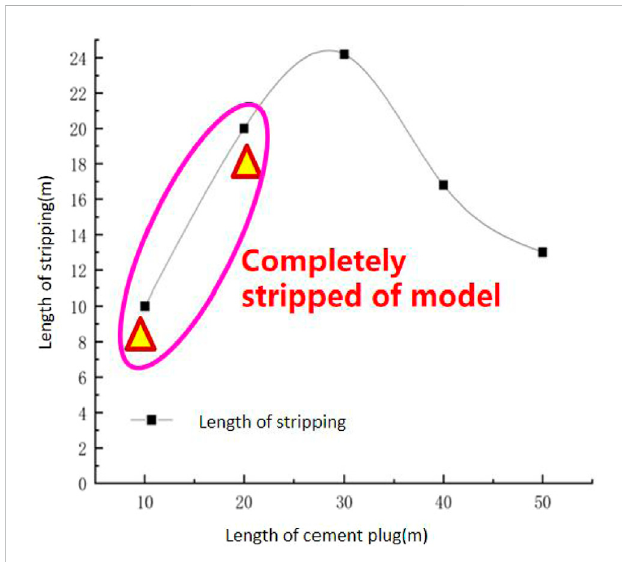
FIGURE 13 Line diagram of strip length changing with cement plug length.